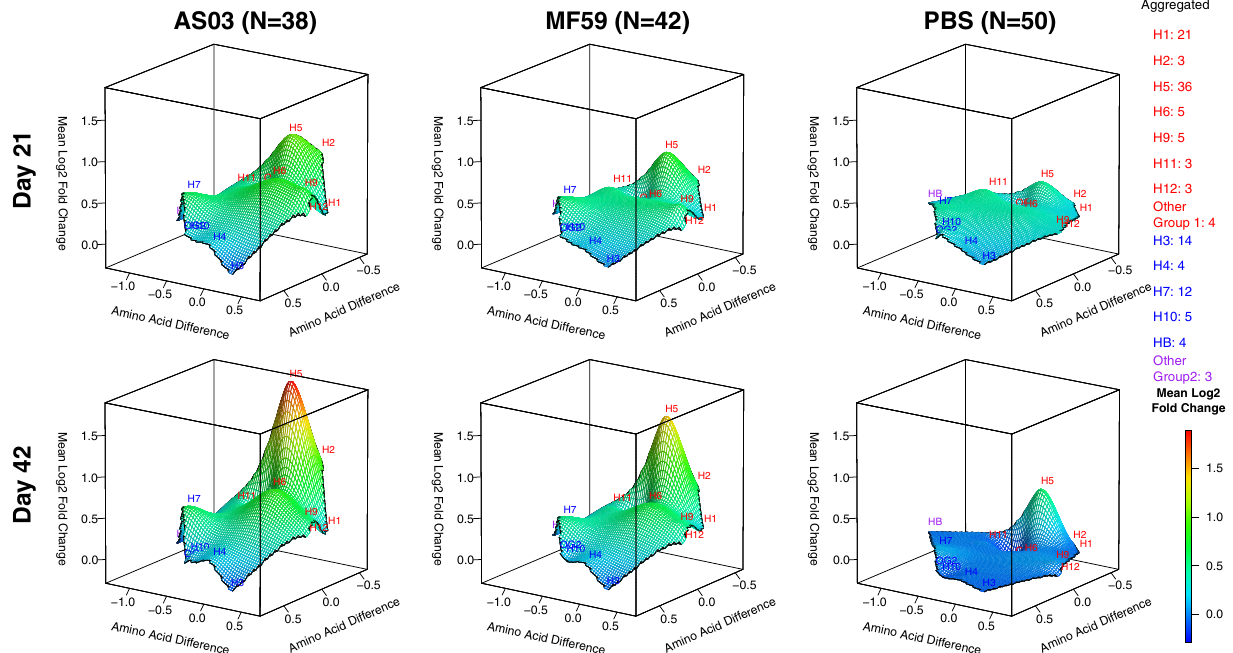
Fig. 5 Adjuvants boosted IgG antibodies against head H5 HA proteins post second dose. IgG antibody landscapes for HA1 subunit antigens based on mean log 2 fold change relative to pre-vaccination adjusted for seasonal in fl uenza vaccination (Experiment 1). In red: Group 1 HA1 antigens, in blue: Group 2 HA1 antigens, in purple: in fl uenza B HA1. The y and x axes project antigen protein sequence divergence as measured in the number of amino acid differences between antigen protein using multidimensional scaling. For each antigen, fi rst the mean log 2 fold change in antibody fl uorescent intensity relative to pre-vaccination adjusted for prior seasonal in fl uenza vaccination was determined (LSMEAN). For subtypes with multiple antigens, the mean LSMEAN and MDS dimensions were used to present the results in the 3D space.